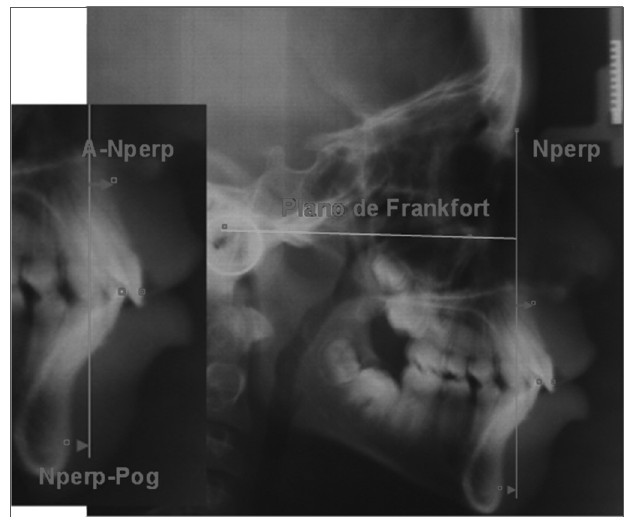
Figura 5. NperpA e NperpPg - NperpA, distância linear do ponto A até a linha Nasio perpendicular; NperpPg, distância linear do ponto Pog até a linha Nasio